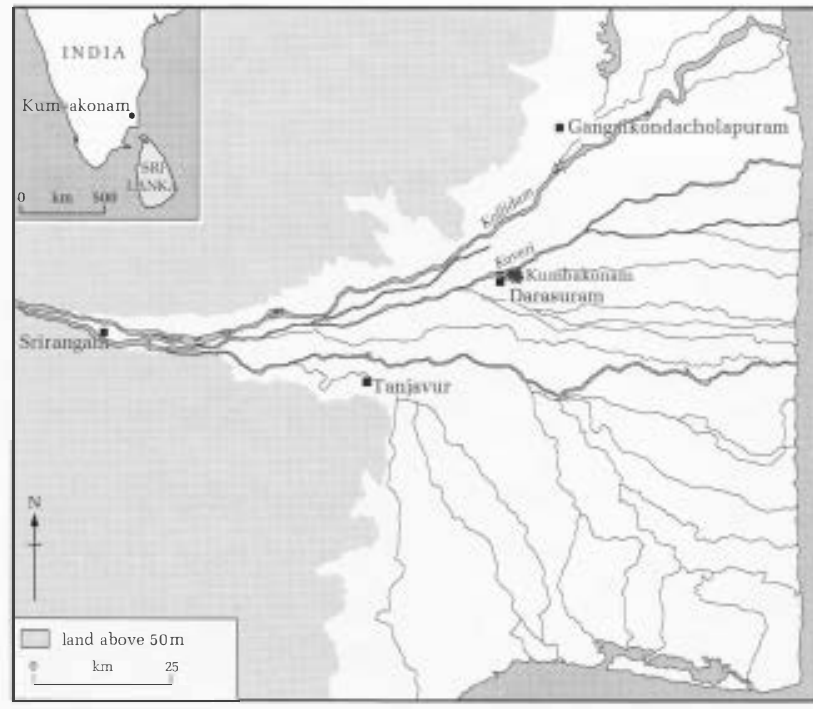
Figure 1 The location of the cityofKumbakonamnearthe apex of the delta of the Kaveri River, southeastern India.